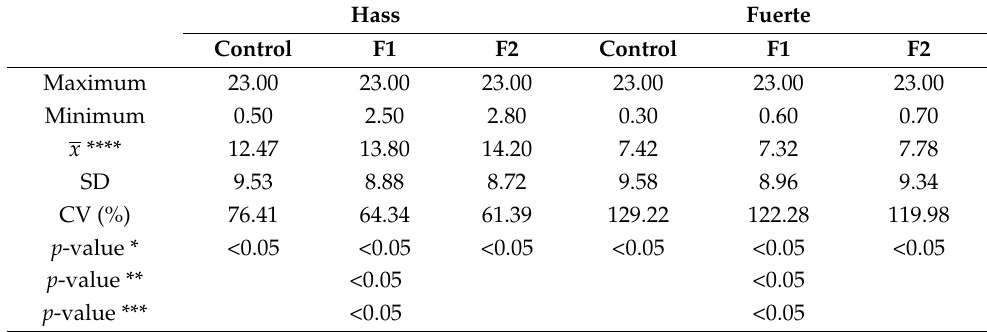
Table 9. Firmness (kg f /cm 2 ) of control and coated avocados.